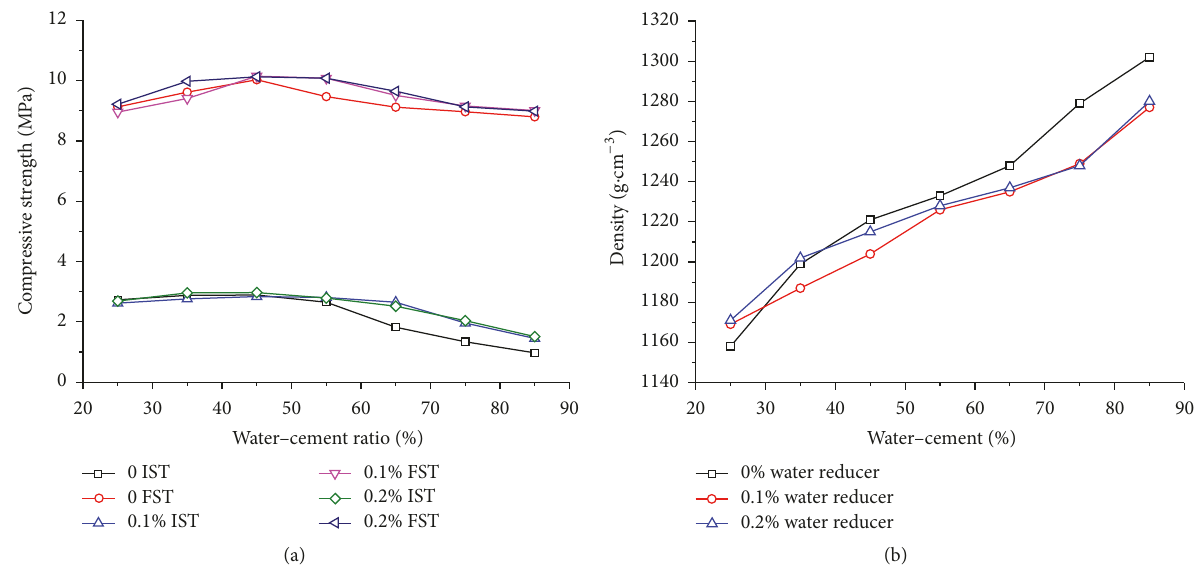
Figure 5: Effect of water–cement ratio and water reducer on compressive strength.